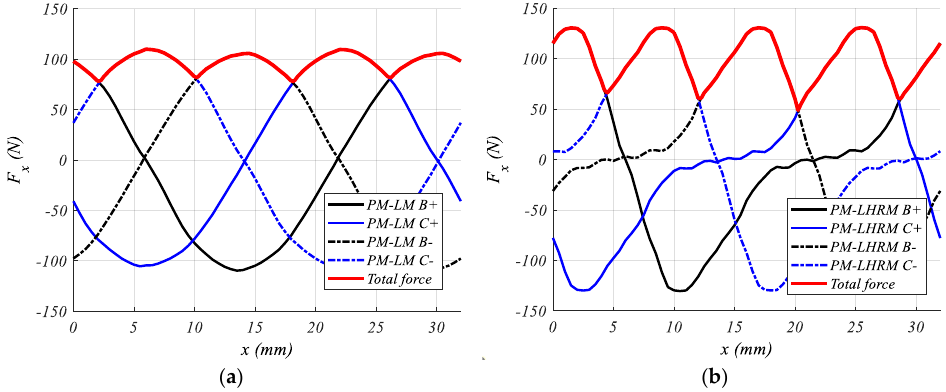
Figure 9. ( a ) Detent force comparison results at s = 4 mm. ( b ) Phase force comparison results for a current density of 10 A/mm 2 and shift = 4 mm.